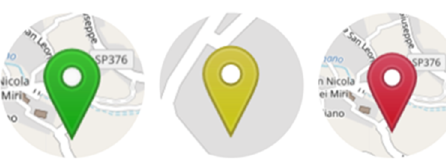
Figure 5. The Neighborhood geometaphor.